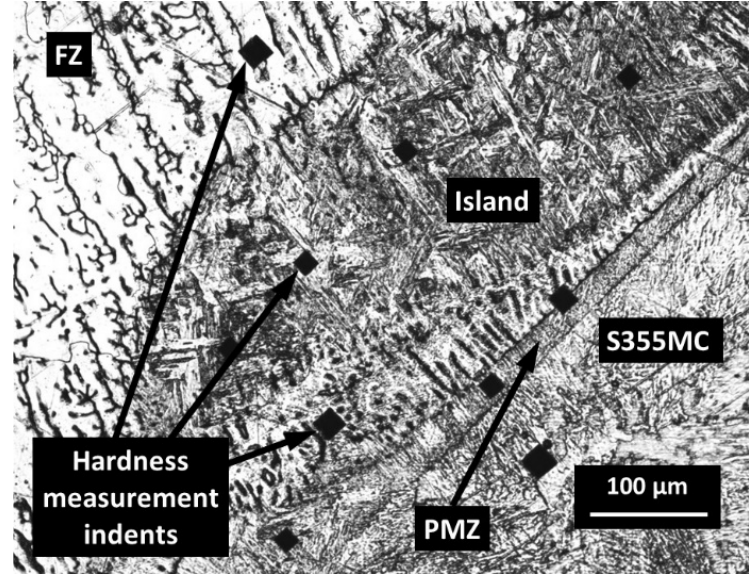
Figure 10. Microstructure of FZ/S355MC with the hardness test’s indentations.